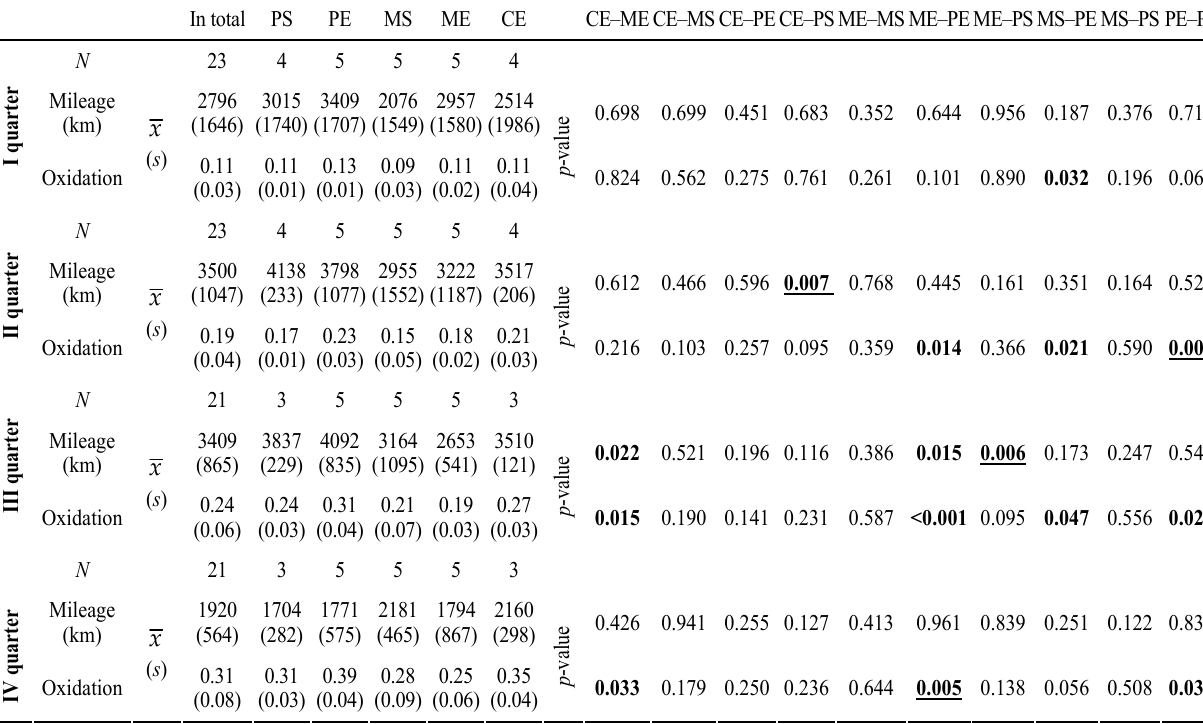
N —the number of samples tested, x —arithmetic average, s —standard deviation, * p -value resulting from the application of Student’s t test for dependent samples. Oil groups (i.e., CE–ME) mean a juxtaposition of two differential oil groups. A comparison of results for individual groups allows to indicate similar oils or oils that